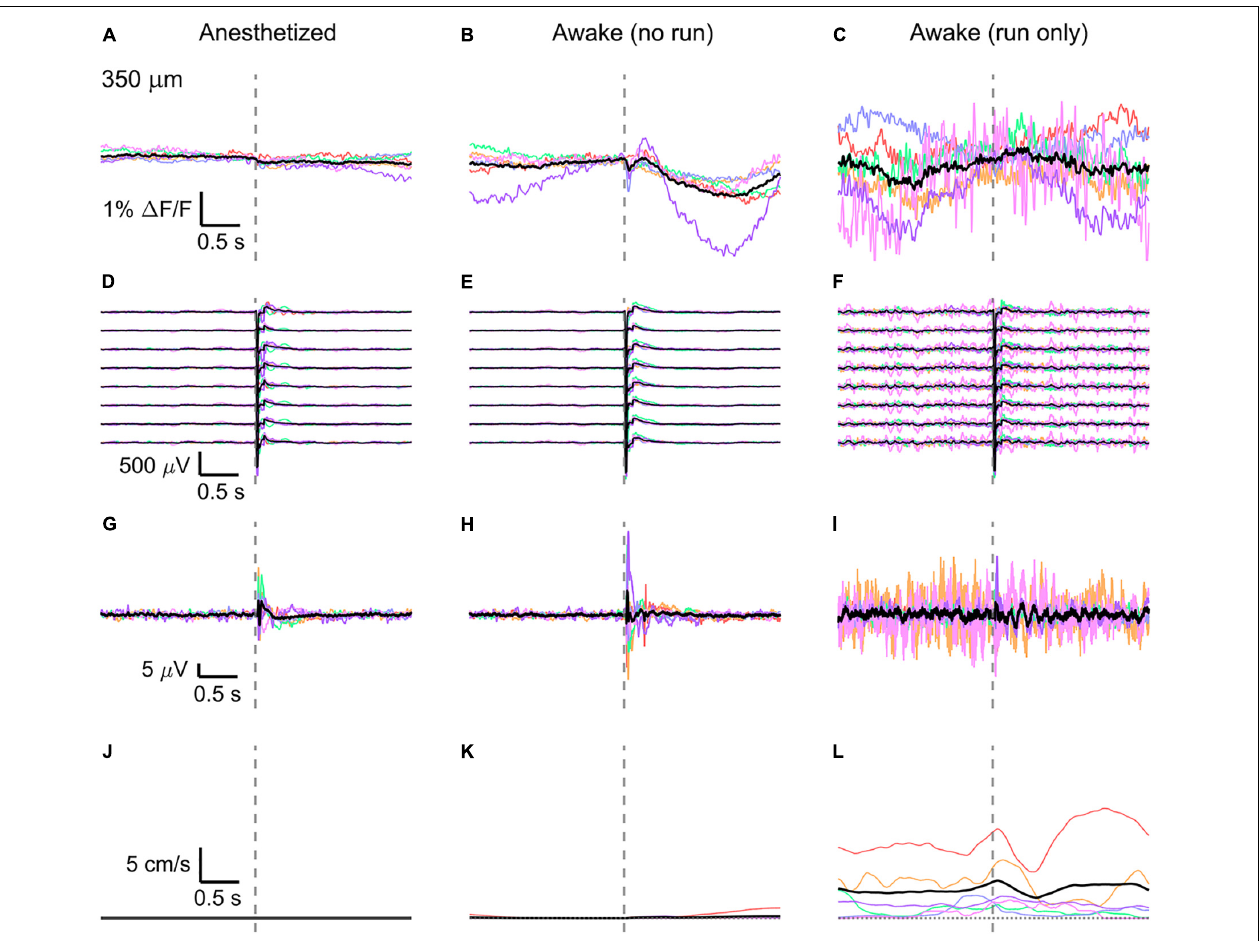
FIGURE 5 | Average VSD signal 350 µ m below dura and LFP, both in barrel cortex, ECoG, and running speed in response to a facial air puff (six mice). Average VSD responses evoked by an air puff to the vibrissae and cheek of the mouse in layer IV (350 µ m below dura) recorded in 375 × 24 × 5 µ m 3 and 375 × 12 × 5 µ m 3 box-scans in 6 mice (A) during anesthesia (131, 189, 125, 138, 122, 136 trials), (B) in awake mice during resting (119, 174, 124, 121, 107, 112 trials), and (C) in awake mice during running (16, 5, 8, 12, 2, 22 trials). (D–F) Corresponding average LFP recorded by eight electrodes (every 4th channel of the linear probe, tip at 850 µ m below dura, bottom LFP trace: 800 µ m, top LFP trace: 100 µ m below dura, (cid:49) depth = 68 µ m between adjacent traces). Corresponding (G–I) average ECoG and (J–L) average speed. Each mouse is indicated by a different color; the overall average is shown in black. Gray dashed line marks the air puff